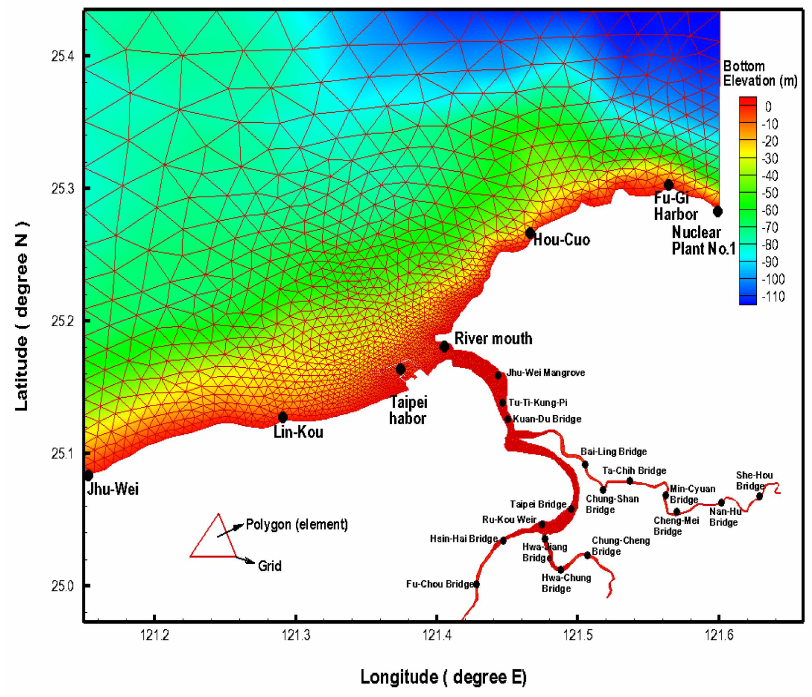
Figure 3. The topography of the Danshuei River estuarine system and its adjacent coastal and unstructured grid for the computational